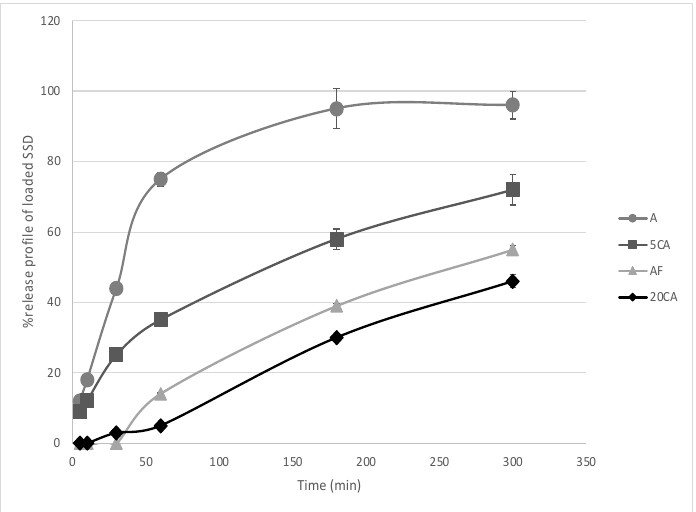
Figure 4. Percent release of loaded SSD from different hydrogel combinations: A (circle), AF (triangle); 5CA (square), 20CA (rhombus). Release tests (n = 3) were performed at 37 °C in simulated wound fluid [42] composed of CaCl 2 anhydrous 0.02 M; NaCl 0.4 M, tris methylamine 0.08 M (final pH 7.5).